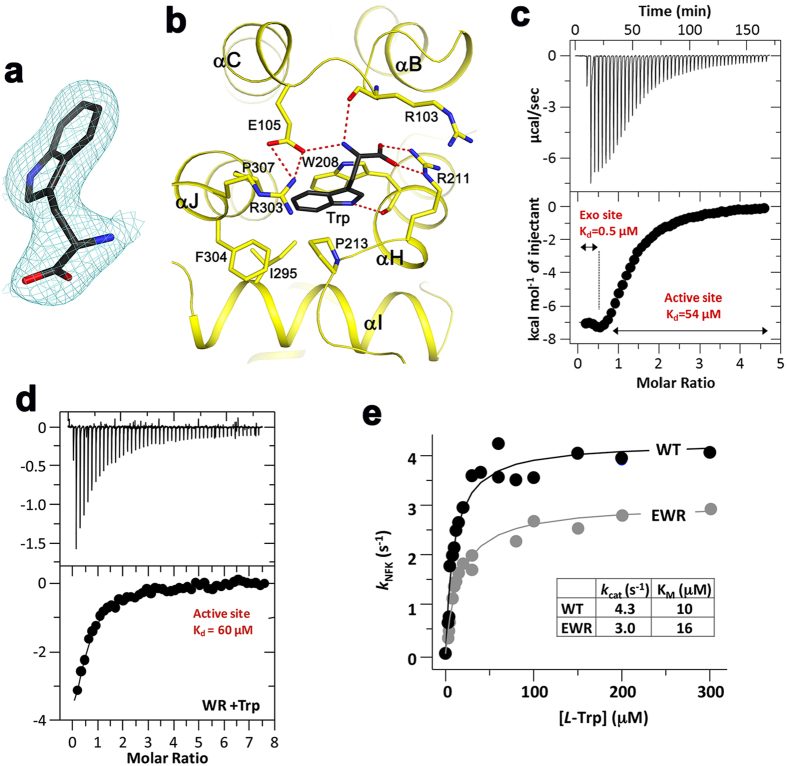
A novel exo site for L-Trp in hTDO.(a) Omit Fo–Fc map at 2.5 Å resolution for L-Trp in the exo site of subunit A, contoured at 4.5σ. (b) Schematic drawing showing the interactions between L-Trp and the exo site. Hydrogen-bonding and ionic interactions are indicated with the dashed lines in red. (c) ITC data for wild-type hTDO demonstrating the presence of two L-Trp binding sites, with association constants of 2.06 ± 1.34 × 106 M−1 (Kd~0.5 μM) and 1.84 ± 0.04 × 104 M−1 (Kd~54 μM). (d) Representative ITC titration of the WR exo site mutant with Trp in the ferric state, showing binding only to the active site. (e) Michaelis-Mikenten plots of the wild type (WT) and EWR mutant reactions showing that the exo site does not significantly perturb the kcat and Km of the enzyme.